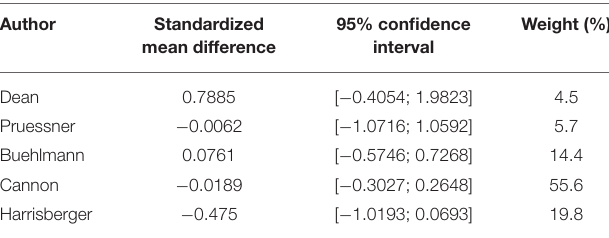
TABLE 2A | Summary of group-diffferences between transition-group and non-transition group for each study (right